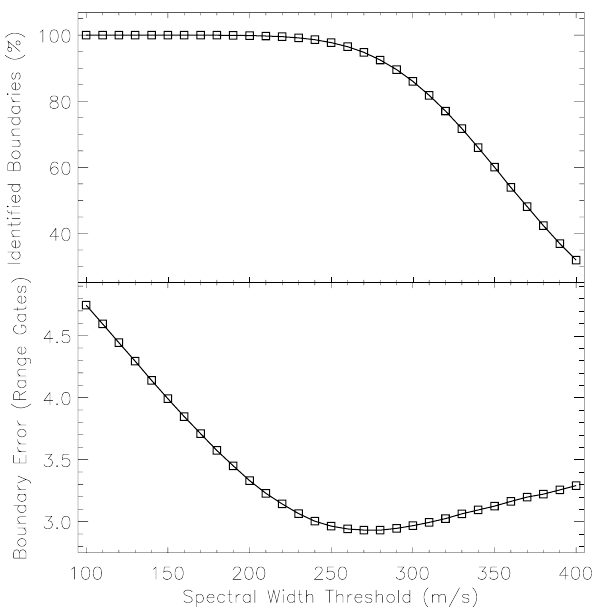
Fig. 2. The variation of the percentage of identified boundaries and the rms boundary error with changing spectral width threshold, as determined theoretically for algorithm